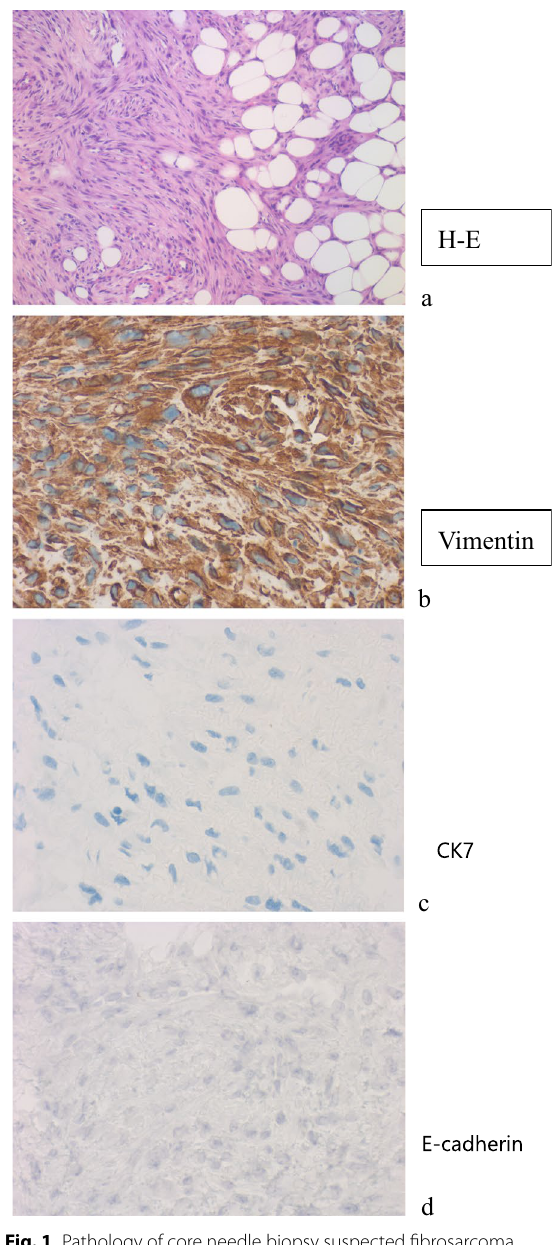
Fig. 1 Pathology of core needle biopsy suspected fibrosarcoma. Core needle biopsy revealed atypical spindled tumor cells ( a ) with Vimentin expression highly positive ( b ). Epithelial markers CK7 ( c ) and E-cadherin ( d ) are